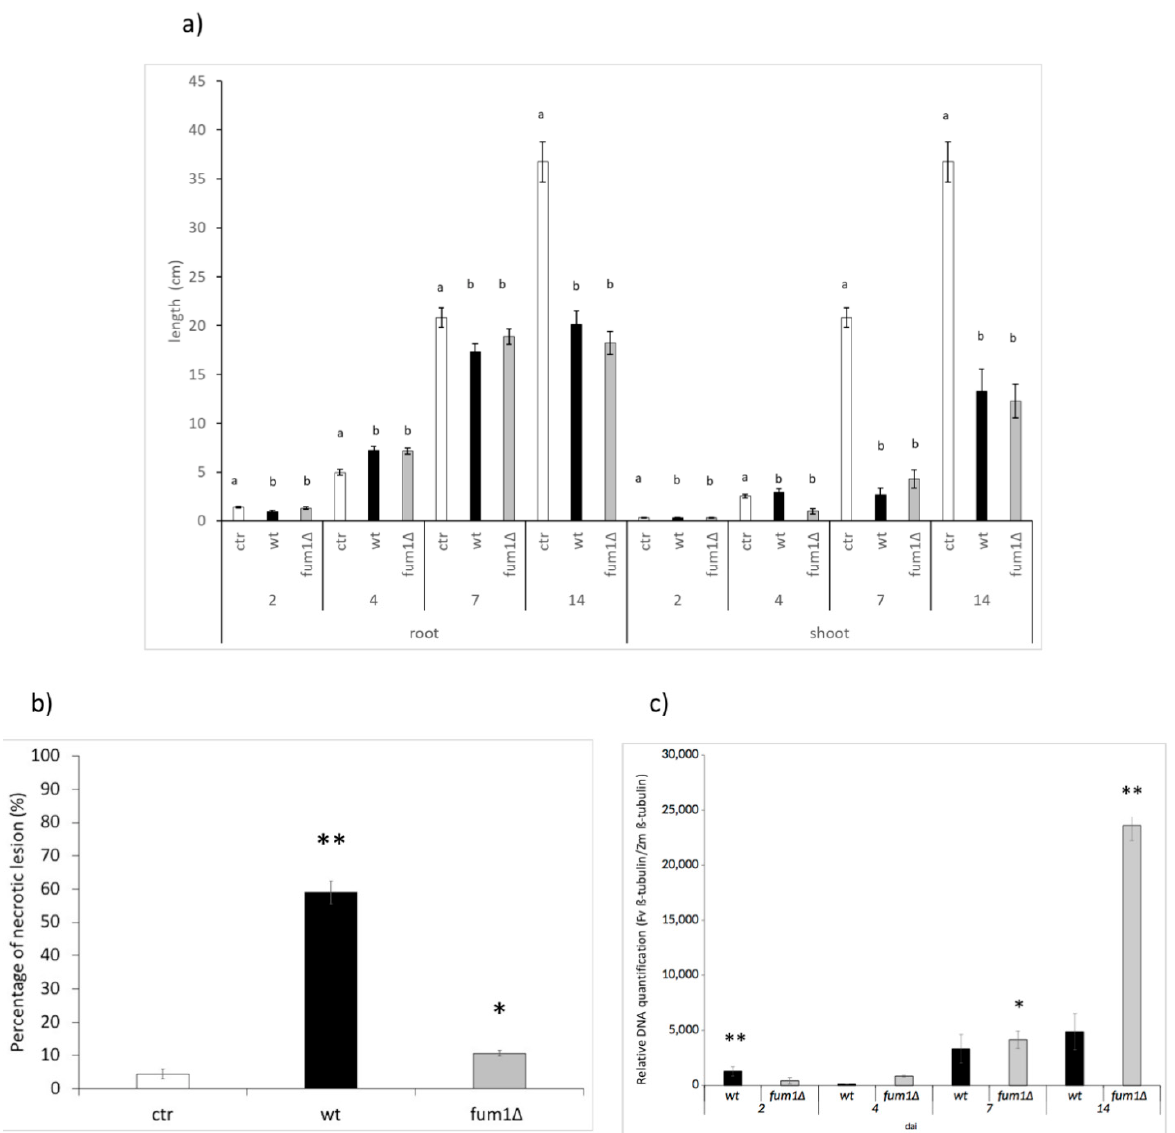
Figure 2. ( a ) Root and stem elongation in maize kernels mock-infected (ctr) or infected with F. verticillioides wild-type (wt) or mutant ( fum1 ∆ ) after 2, 4, 7, and 14 days after infection (dai). Data are presented as the mean from two experiments, n = 20 seeds, results are the mean ± std error. Significance ( p ≤ 0.05) was assessed by one-way ANOVA followed by Tukey’s test (groupings indicated by a,b). ( b ) number of roots showings symptoms of necrosis at 14 dai in the non-infected control (ctr), wt, and fum1 Δ infected seedlings. ( c ) DNA extracted from infected and non-infected seedlings at 2, 4, 7, and 14 dai was examined by qPCR with primers specific to F. verticillioides and Z. mays genes coding for β -tubulin. Total height of each bar indicates the quantity of fungal DNA relative to the total DNA detected. Asterisks indicate a significant difference at same time point from ctr in ( b ) and from the wt in c) (Student's t-test: * p < 0.05; ** p < 0.01).